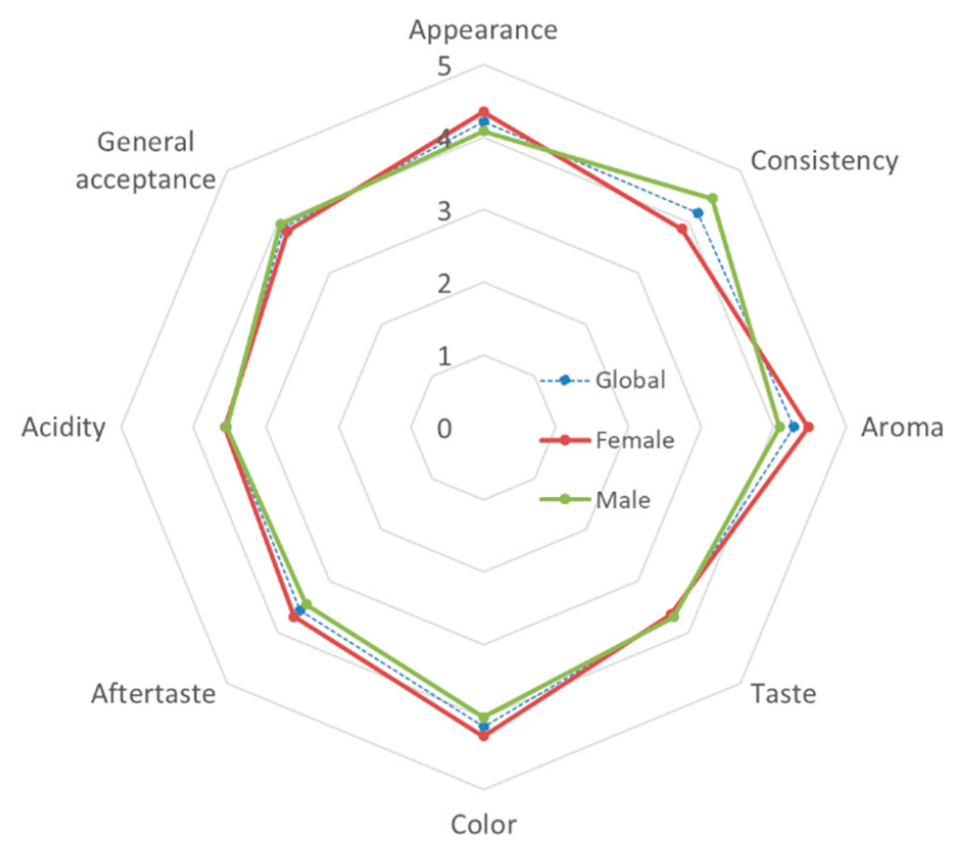
Figure 2. Sensory profile of the goat colostrum yogurt (GCY) using a five-point scale. In general, the panelists showed an average overall acceptance close to 4 points (3.89), with acidity being the sensory attribute that received the lowest score (3.55) and aroma the highest (4.27). By gender, men found a significantly more pleasant consistency than women did ( p = 0.035), while women gave better scores for taste, although the differences did not become statistically significant ( p =